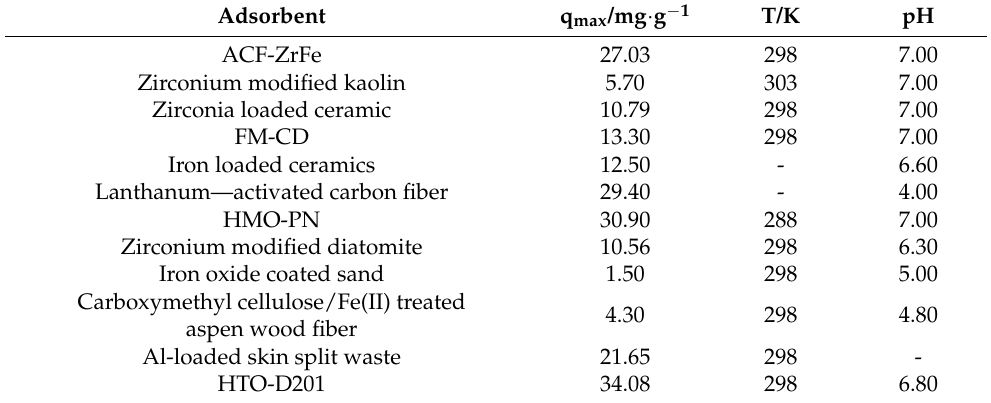
Table 4. Comparison of phosphorus adsorption between HTO-D201 and other composites adsorbents.